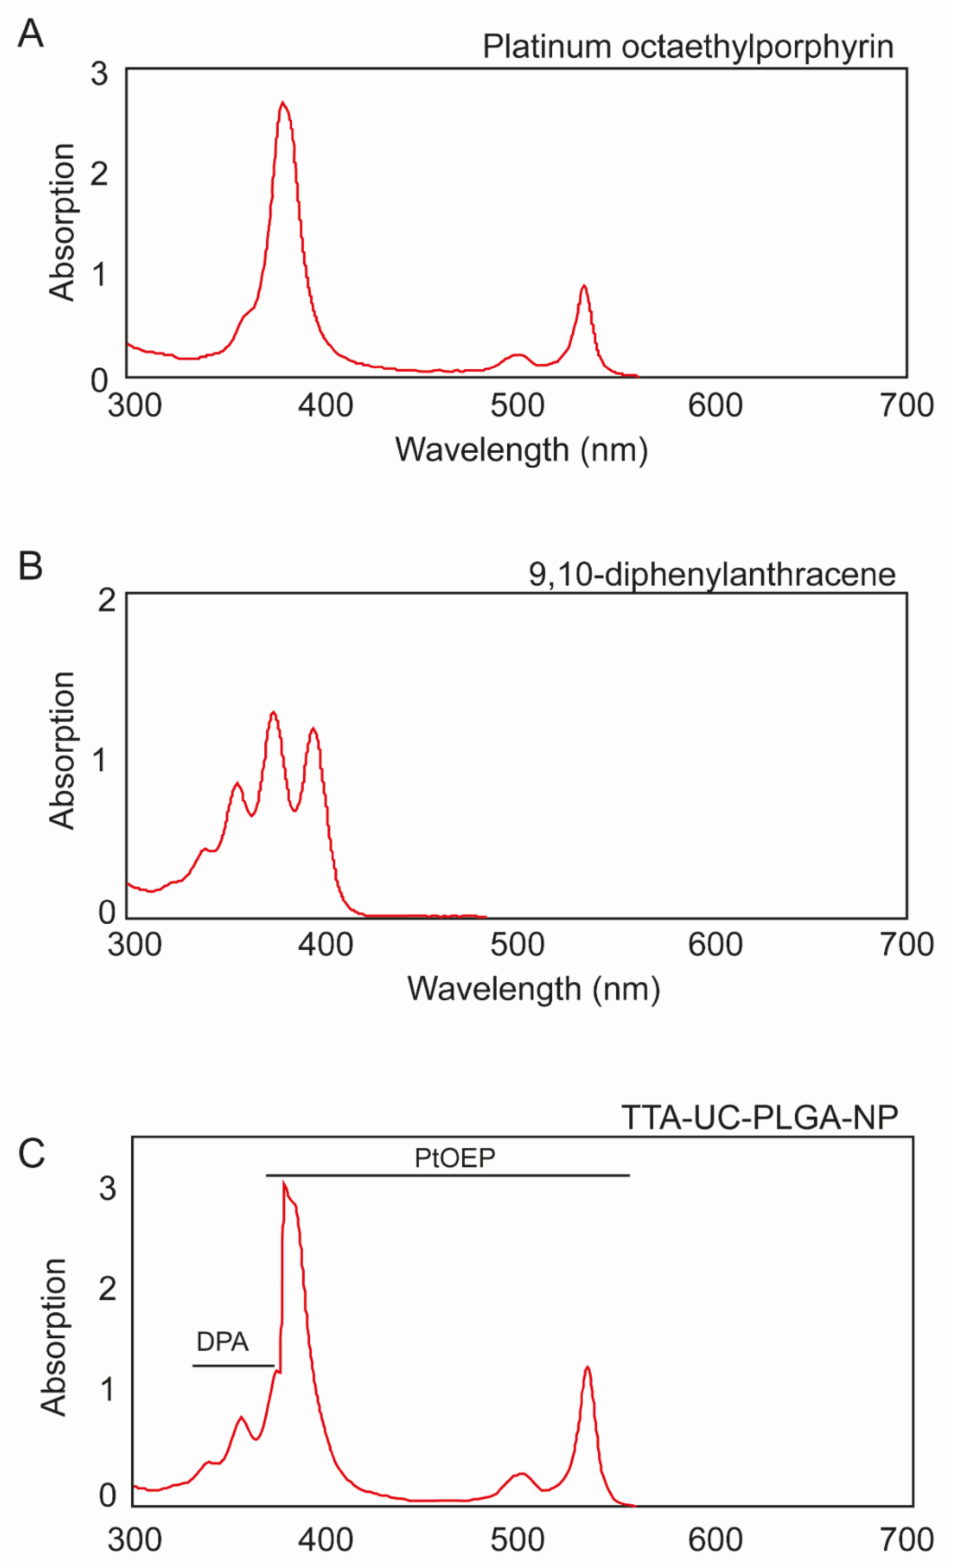
Figure 2. Individual absorption spectra of ( A ) platinum octaethylporphyrin (PtOEP) and ( B ) 9,8-dip- henylanthracene (DPA), each dissolved in dimethylformamide (DMF). ( C ) TTA-UC-PLGA-NPs were hydrolysed overnight in 0.8 M NaOH at 37 ◦ C, and the absorption spectrum of co-encapsulated PtOEP and DPA was